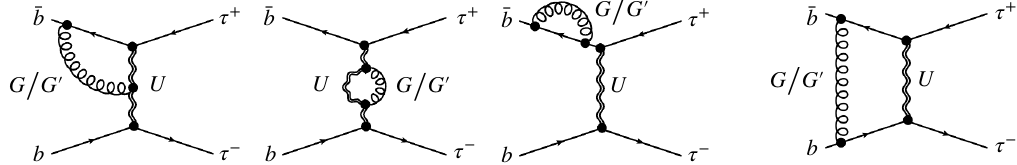
b Figure 2 . Virtual O ( α s ) corrections to the singlet vector LQ contribution in DY ditau production, with a gluon ( G ) or a coloron ( G 0 ) running in the loop. The three graphs on the left show the factorisable contributions. They arise from LQ-quark-lepton vertex corrections as well as from LQ and quark wave function corrections. The diagram on the far right depicts a non-factorisable contribution due to a box diagram. For additional explanations consult the main